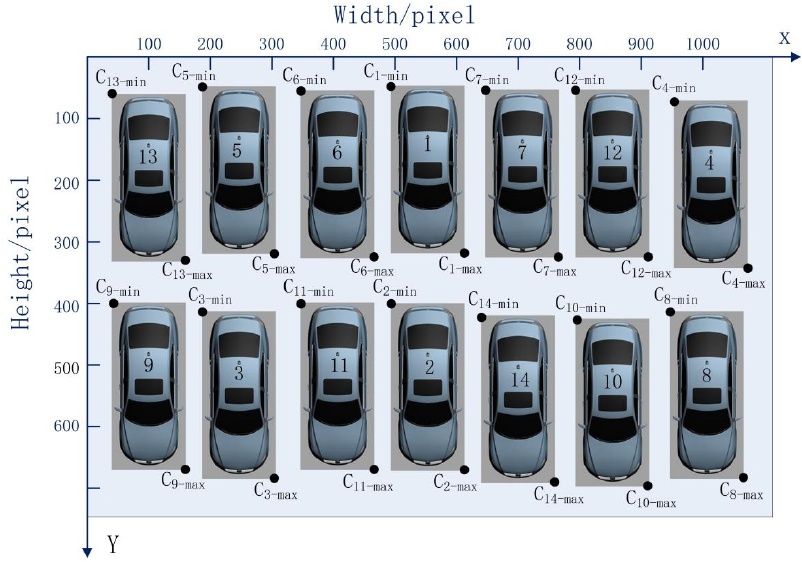
Figure 4. Random parking space numbers. The positions of the upper left and lower right corners of each parking space were defined as C i − min ( x min , y min ) i = 1, · · · , 14 and C i − max ( x max , y max ) i = 1, · · · , 14. The